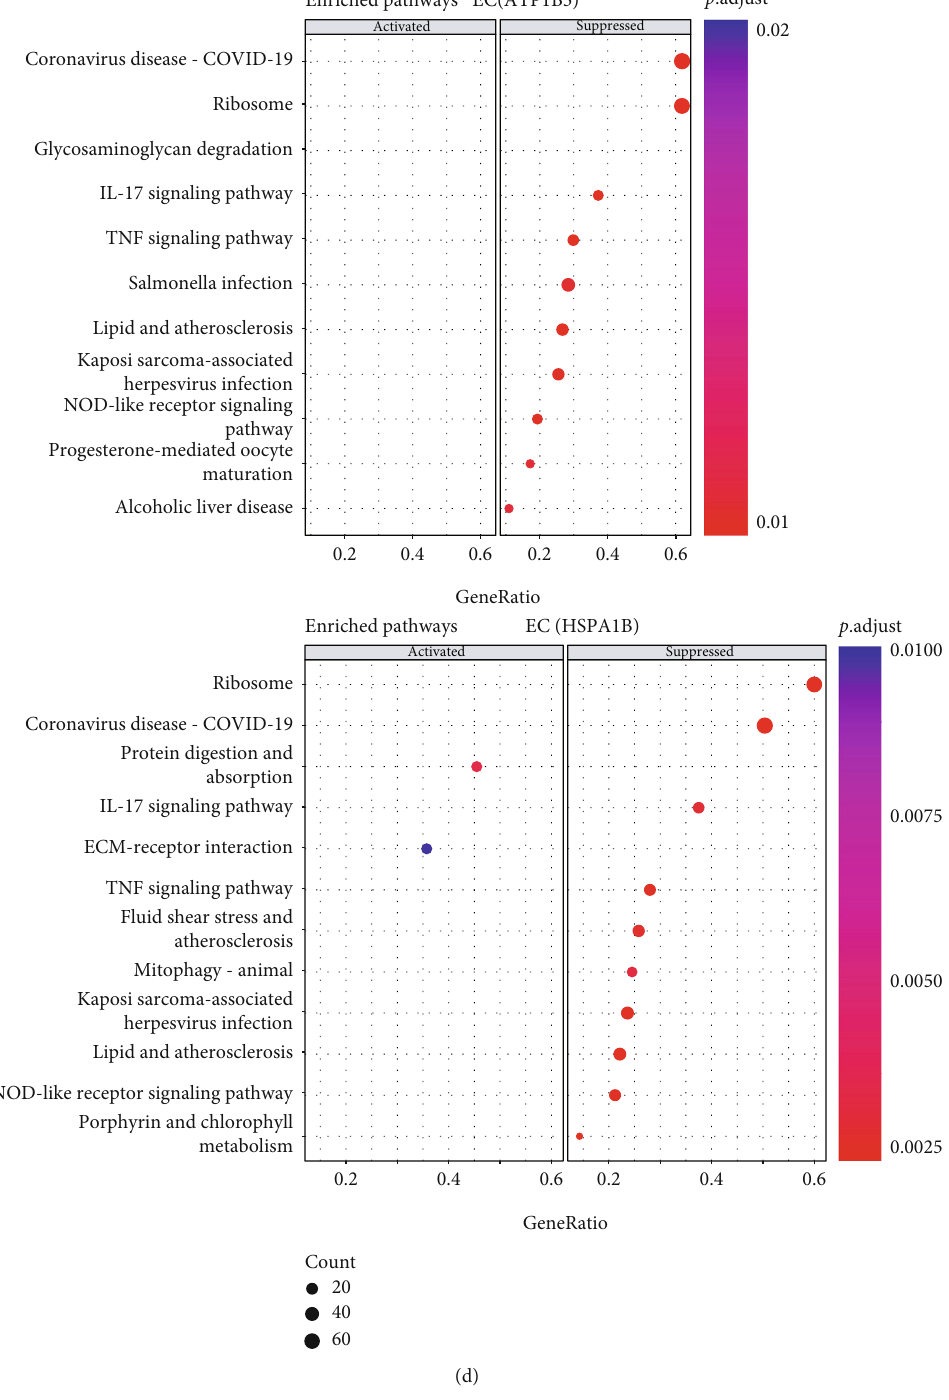
Figure 3: Comparison of TNBC endothelial cell subclusters with the normal human breast tissue. (a) Split UMAP plot showed the distribution of endothelial cell subclusters in both normal biopsies and TNBC biopsies. (b) Stacked bar plot showed a comparison of the frequency of endothelial cell subclusters, normal vs TNBC biopsies. (c) Volcano plots showed the distribution of DEGs calculated from endothelial cell subcluster EC (ATP1B3) and EC (HSPA1B). (d) Dot plots showed up and downregulated pathways in the endothelial cell subcluster EC (ATP1B3) and EC